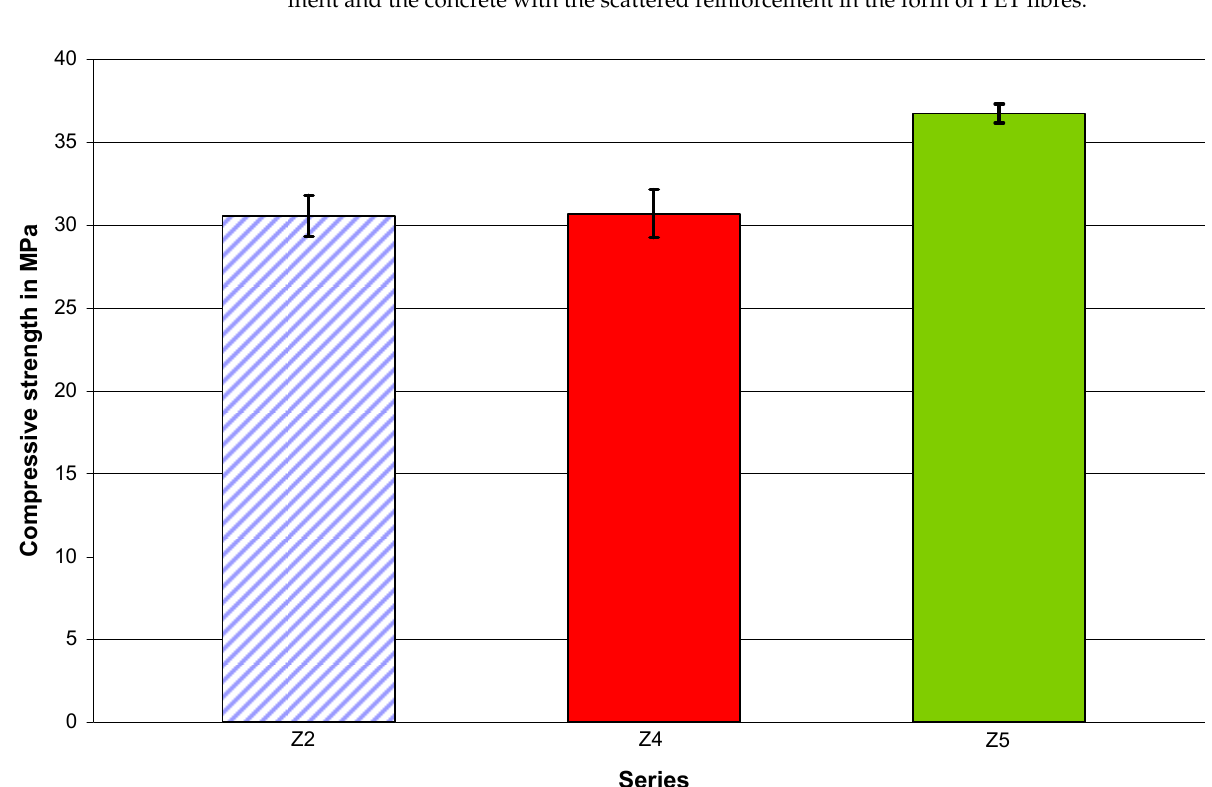
Figure 10. Results of the flexural tensile strength test for the concretes with the scattered rein ‐ forcement in the form of PET fibres (length 62 mm), polypropylene fibres, and steel fibres. The results presented in Figure 10 show that the highest flexural tensile strength was obtained in the case of the concrete series Z2 with the addition of PET fibres (length—62 mm).